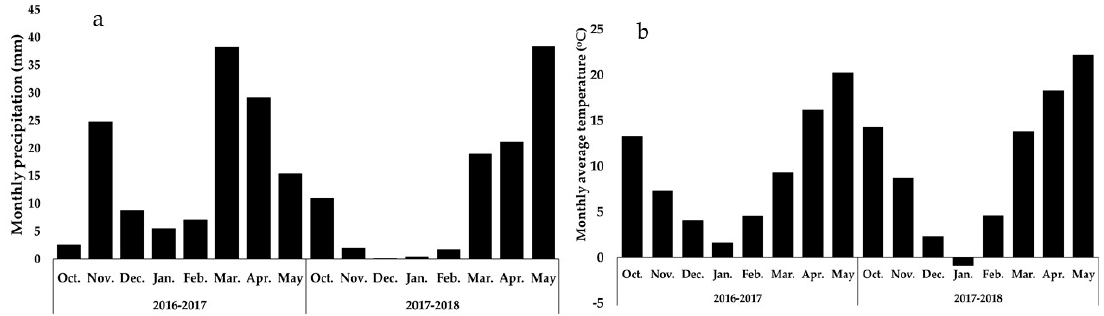
Figure 1. Meteorological data during both cropping seasons: ( a ) Monthly precipitation, ( b ) monthly average